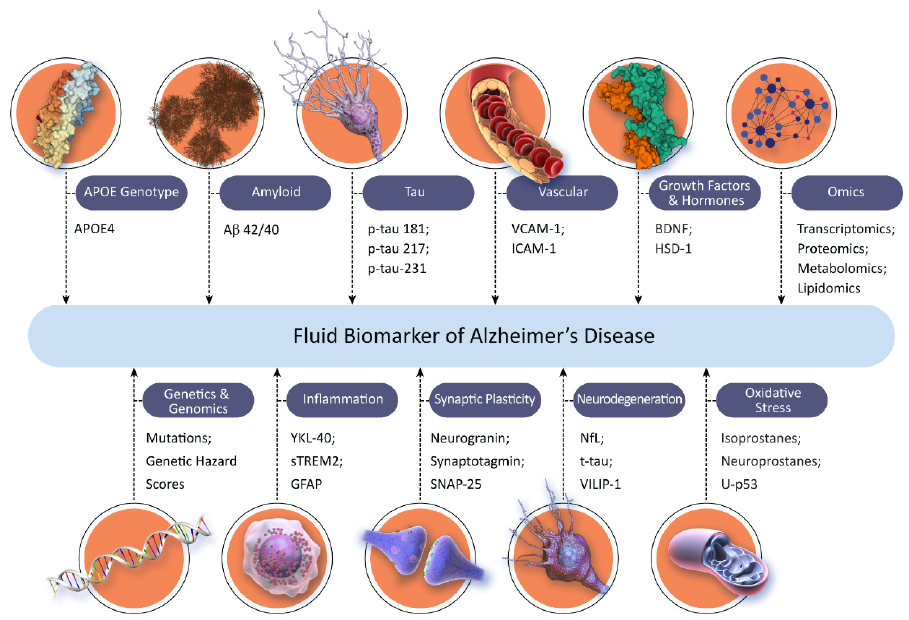
Figure 1. Landscape of fluid biomarkers for Alzheimer’s disease (© J Cummings; illustrator M de la Flor, PhD).